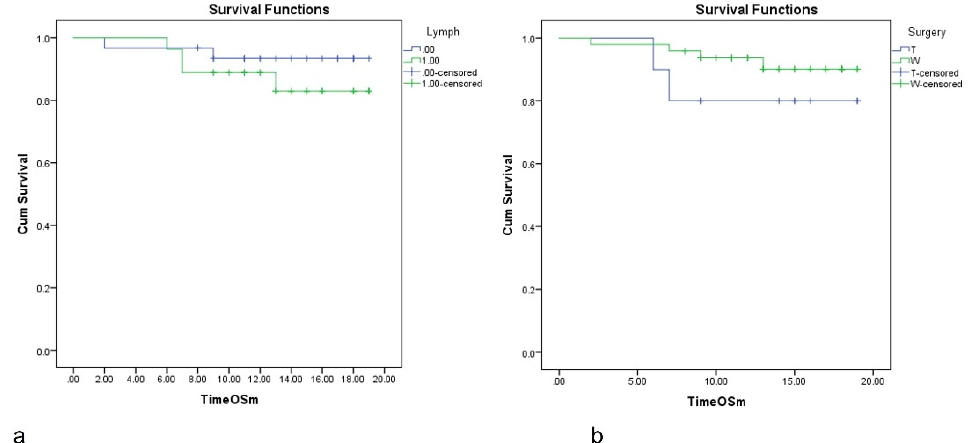
Figure 3. Survival analysis according to the presence of lymphadenectomy associated with the pul- monary resection ( a ) and according to the type of lung resection: T = typical resection (anatomic